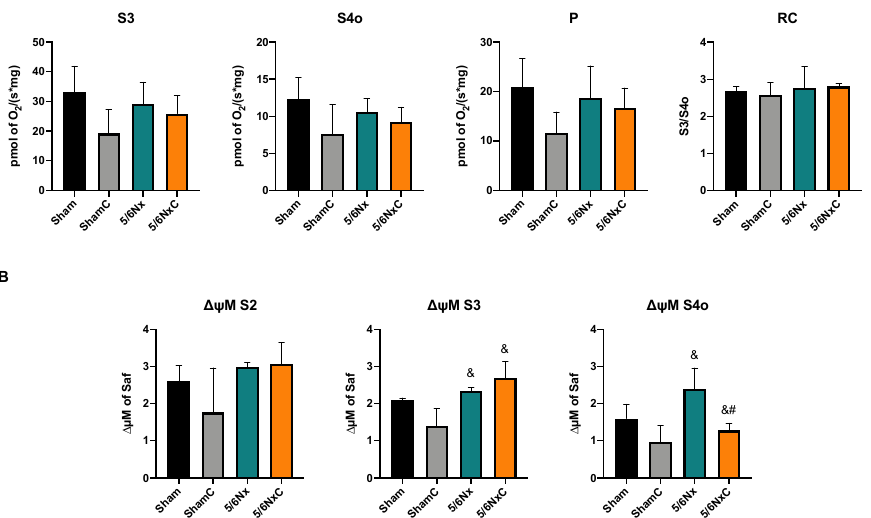
Figure 8. Liver mitochondrial β -oxidation in the four groups of rats studied: Sham, Sham + curcumin (ShamC), five-sixths nephrectomy (5/6Nx), and 5/6Nx + curcumin (5/6NxC). ( A ) Respiration and ( B ) Membrane potential. S3 = State 3, S4o = State 4 induced by oligomycin, P = Oxidative phosphory- lation associated respiration, RC = Respiratory control, ∆Ψ m = Changes in mitochondrial membrane potential, Safranin (Saf). One-way analysis of variance (ANOVA), post hoc Fisher ´ s Least significant difference LSD, Mean ± SD, n = 3. $ p < 0.05 vs. Sham, & p < 0.05 vs. ShamC, # p < 0.05 vs.